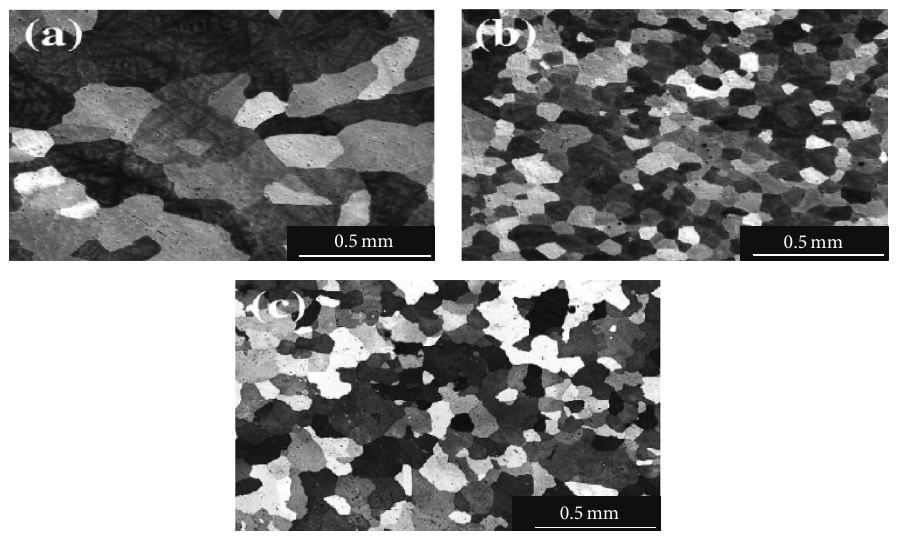
Figure 11: Micrographs representing as-cast (a) Mg-12Li, (b) Mg-12Li-0.03Be-Al, and (c) Mg-12Li-0.03Be-3Al alloys [12].